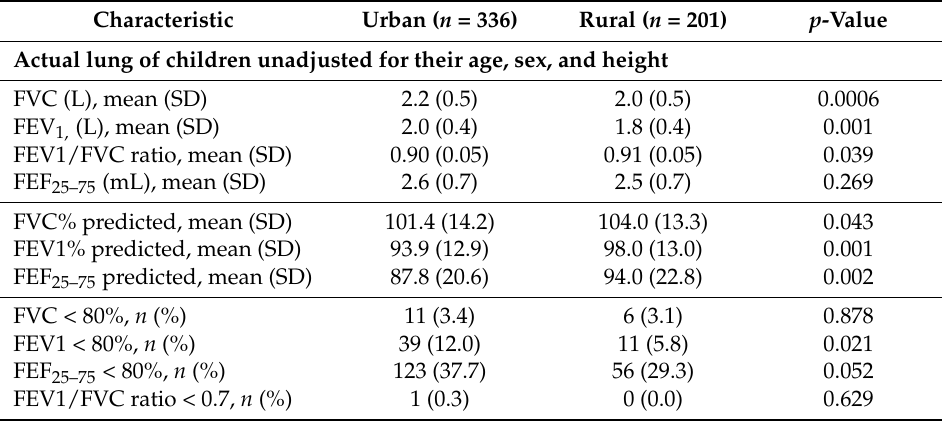
Table 4. Lung function and lung function abnormalities of study participants by urban status. Characteristic Urban ( n = 336) Rural ( n = 201) p